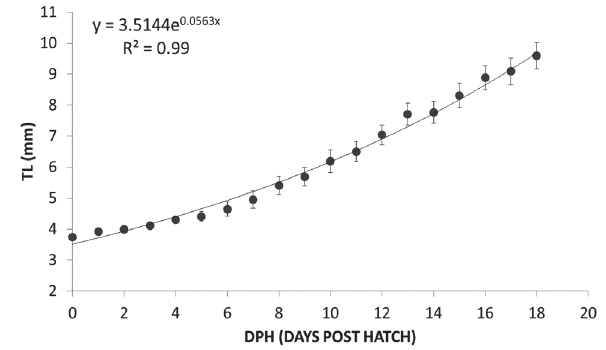
Fig. 4. Changes in total length (TL) from hatching to 18 days post hatch (DPH). Standard deviation (SD) represented by